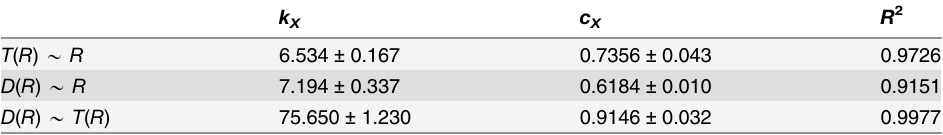
Table 4. The fitting results of “ S ” curves by using gompertze